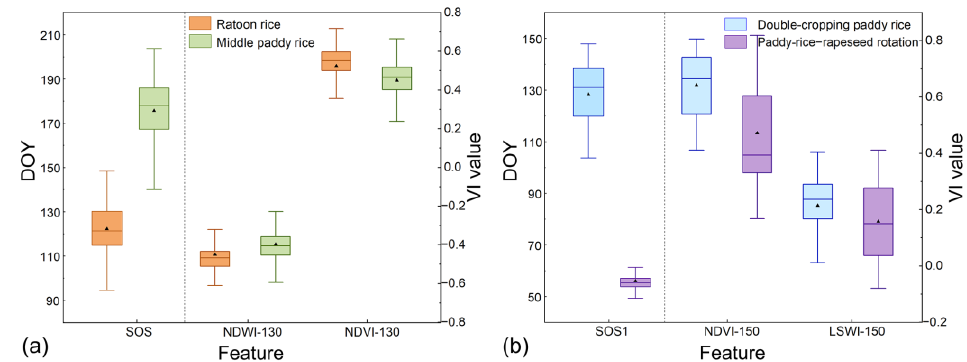
Figure 10. Boxplots of the top three optimal features for ( a ) ratoon rice and middle paddy rice in the single-cropping paddy rice group and ( b ) double-cropping paddy rice and paddy-rice – rapeseed rotation in the double-cropping rice group. The boxes represent the 25th to 75th percentiles, and the bars show the 1.5 interquartile range. Lines and triangles stand for median and mean values, respectively.